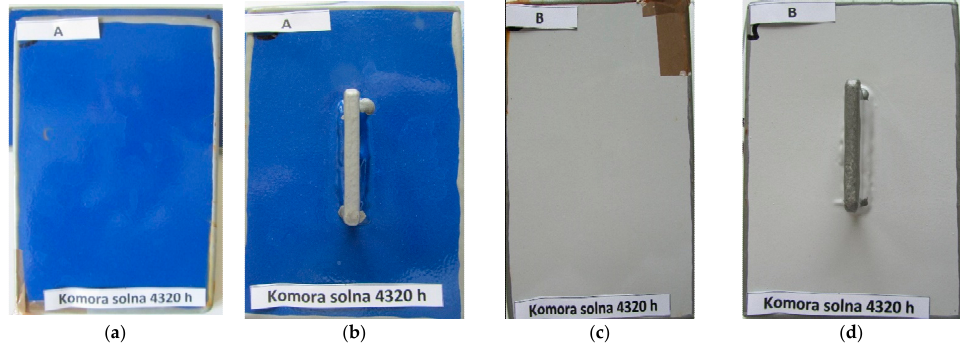
Figure 7. The appearance coatings without scratches after 4320 h of exposure in a salt spray chamber: ( a , b ) system A; ( c , d ) system B.